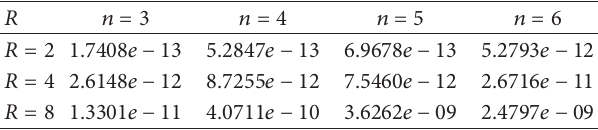
Table 3: Error 𝜀 of Example 1 for different 𝑅